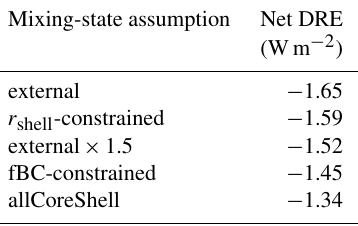
Table 2. The net direct radiative effect (DRE) calculated using each mixing state averaged over the Arctic for